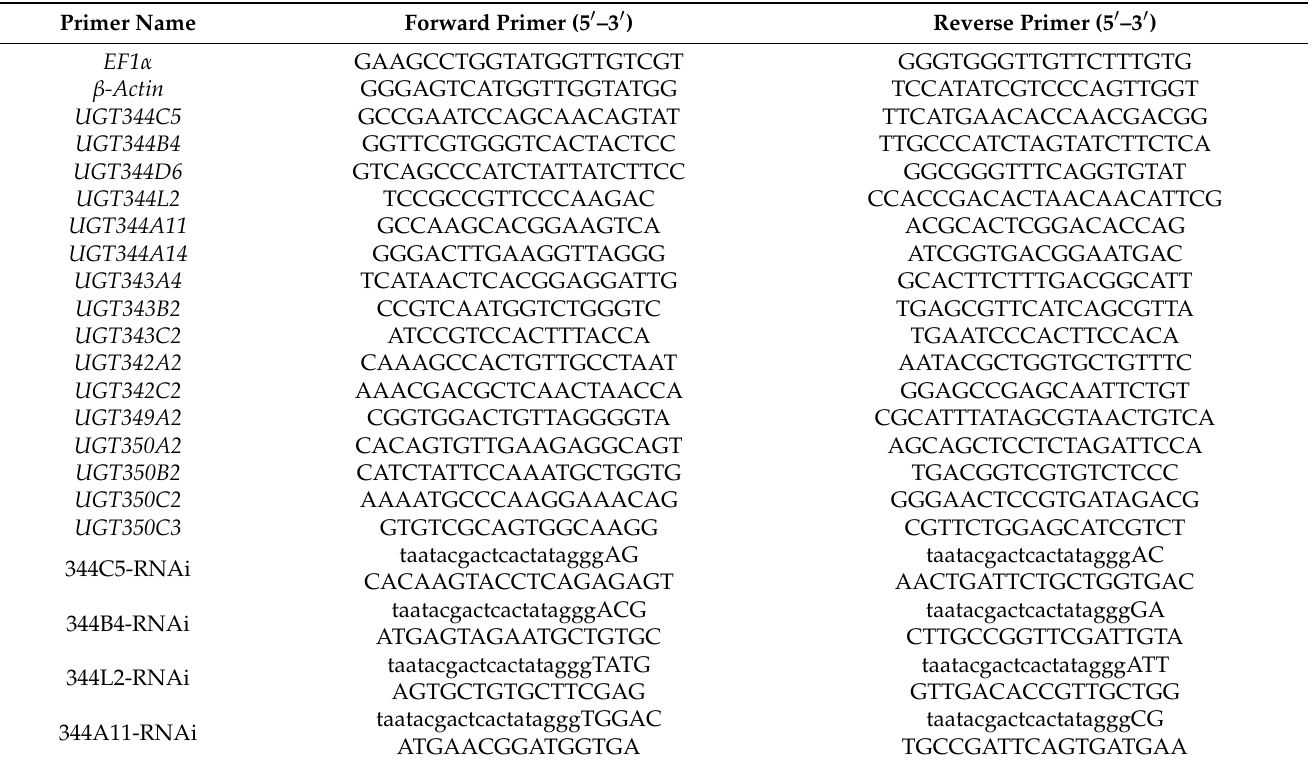
Table 1. Primers used for qRT-PCR analysis and dsRNA